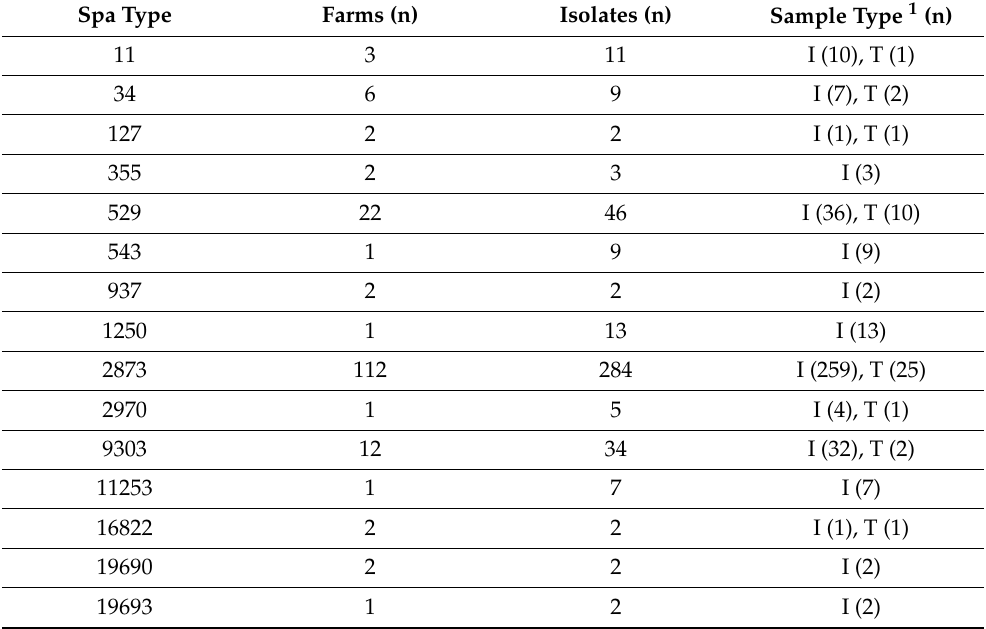
Table 1. Distribution of the S. aureus spa types across Israel. 1 I-individual sample, T-bulk-tank sample. Other spa type that were present in only one sample included 111, 701, 1534, 2346, 2802, 2876, 19691, 19692 and